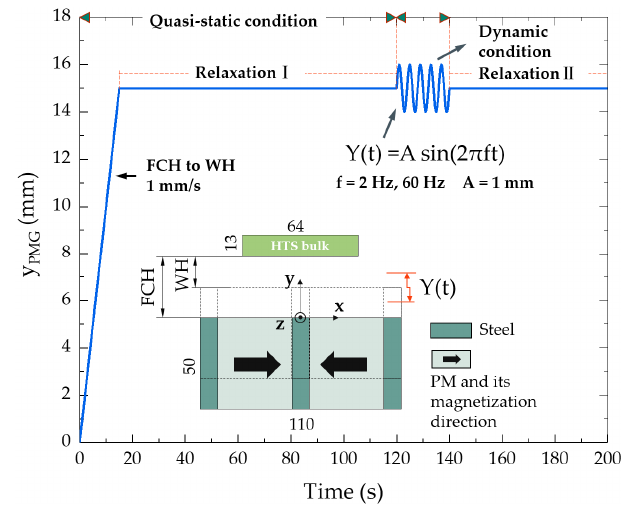
Figure 1. Vertical displacement variation of the permanent magnetic guideway (PMG) and two-dimensional (2D) model for the high-temperature superconducting (HTS) Maglev system. Vibration amplitude A = 1 mm. Field-cooling height (FCH) = 30 mm, working height (WH) = 15 mm. The quasi-static condition from 0 s to 120 s includes the 0–15 s upward movement from FCH to WH and the Relaxation I process from 15 to 120 s. Then, after 20 s of vibration, the second relaxation process (Relaxation II) happened from 140 s to the end.